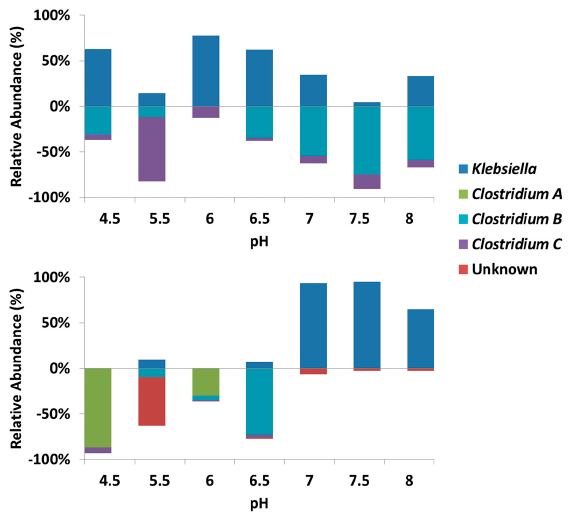
Figure 5. Species affiliated T-RFs (16S rRNA gene target) proportional area for (top) and reset pH approach (bottom) at each pH point. Bars are split based on Klebsiella (top) and progressive pH approach (top) and reset pH approach (bottom) at each pH point. Bars are Clostridium and unknown (bottom) prominence. Klebsiella was identified as K. rennanqilfy , Clostridium split based on Klebsiella (top) and Clostridium and unknown (bottom) prominence. A was identified as C. thermocellum , Clostridium B was identified as C. botulinum and intestinale , and Clostridium C was identified as C. pasteurianum